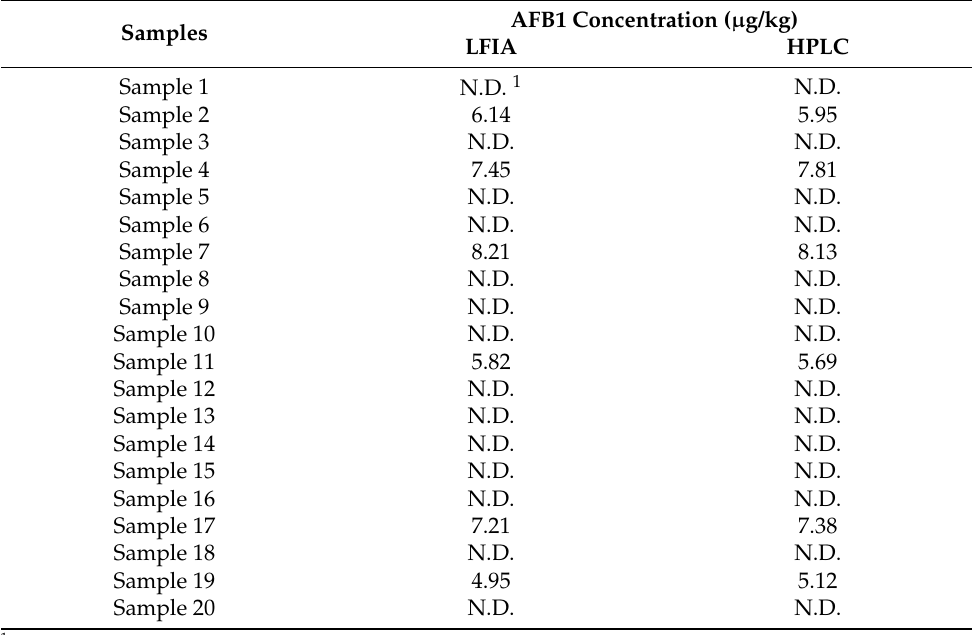
Table 4. Determination of AFB1 in real samples by LFIA and HPLC